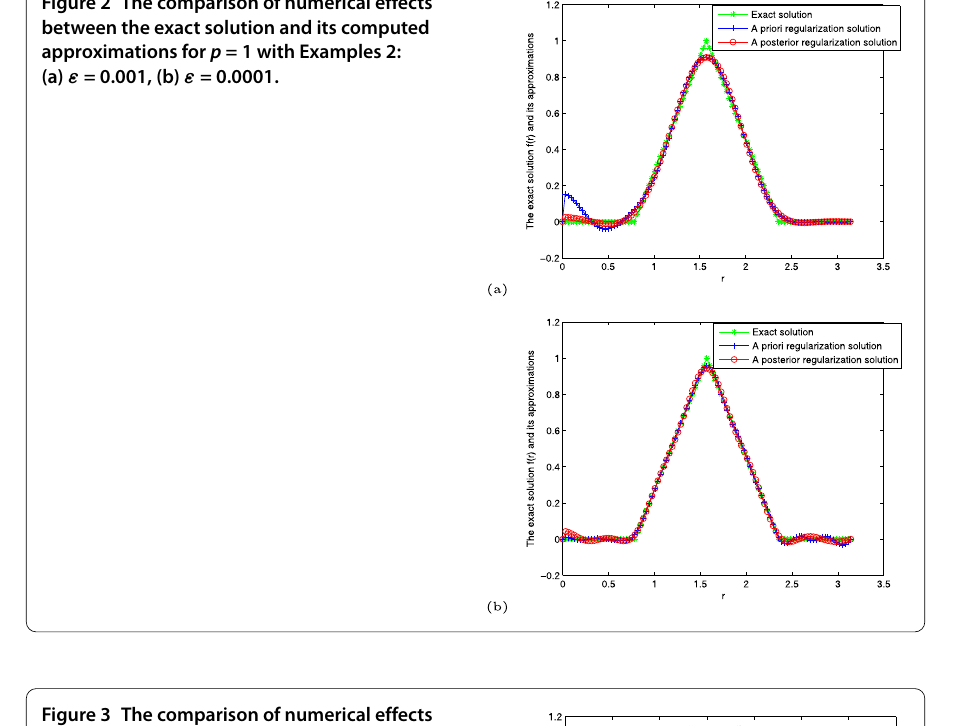
Figure 3 The comparison of numerical effects between the exact solution and its computed approximations for p = 1 with Examples 3: (a) ε = 0.001, (b) ε =